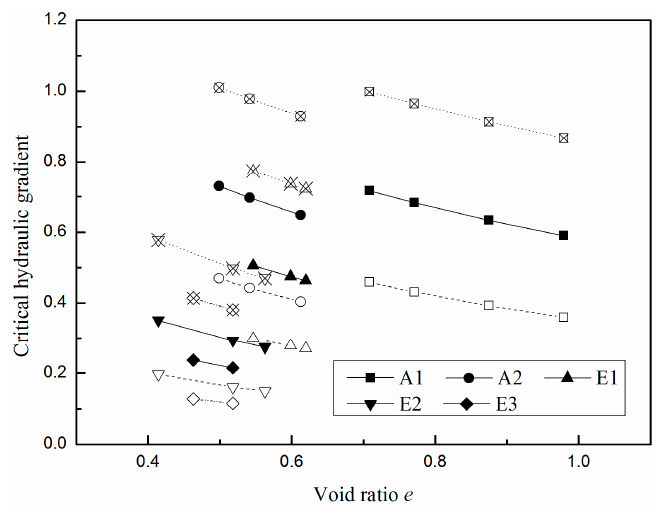
Figure 9. Effects of the soil parameters on the critical gradients.